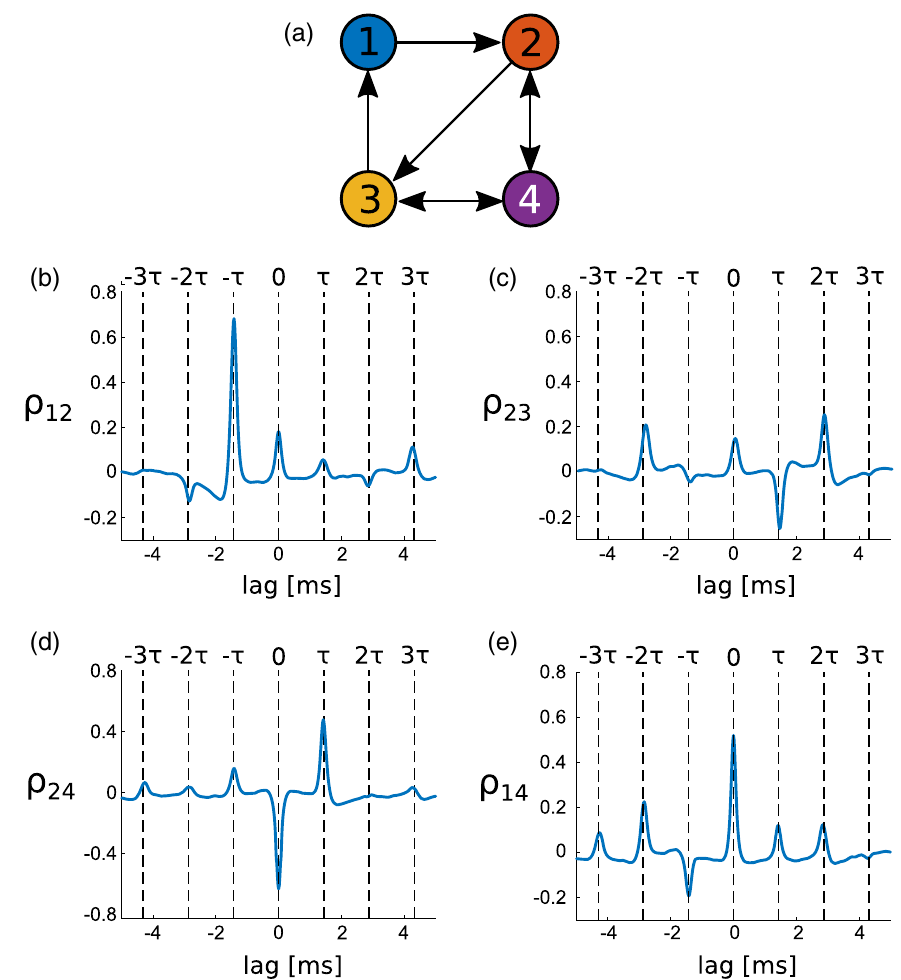
FIG. 11. Time delay determination by cross-correlation of measured time series. In all cases, the coupling delay time is 1.44 ms. (a) The network to be inferred from time series measurements. (b) The cross-correlation between the time series of nodes 1 and 2. A strong peak is observed near − 1 . 44 ms. (c) The cross-correlation between the time series of nodes 2 and 3. A strong negative peak is observed near 1.44 ms and a strong positive peak near − 1 . 44 ms. (d) The cross-correlation between the time series of nodes 2 and 4. A strong peak is observed near 1.44 ms. (e) The cross-correlation between the time series of nodes 1 and 4. Peaks are observed at 1.44 and − 1 . 44 ms, even though there is no link from node 1 to node